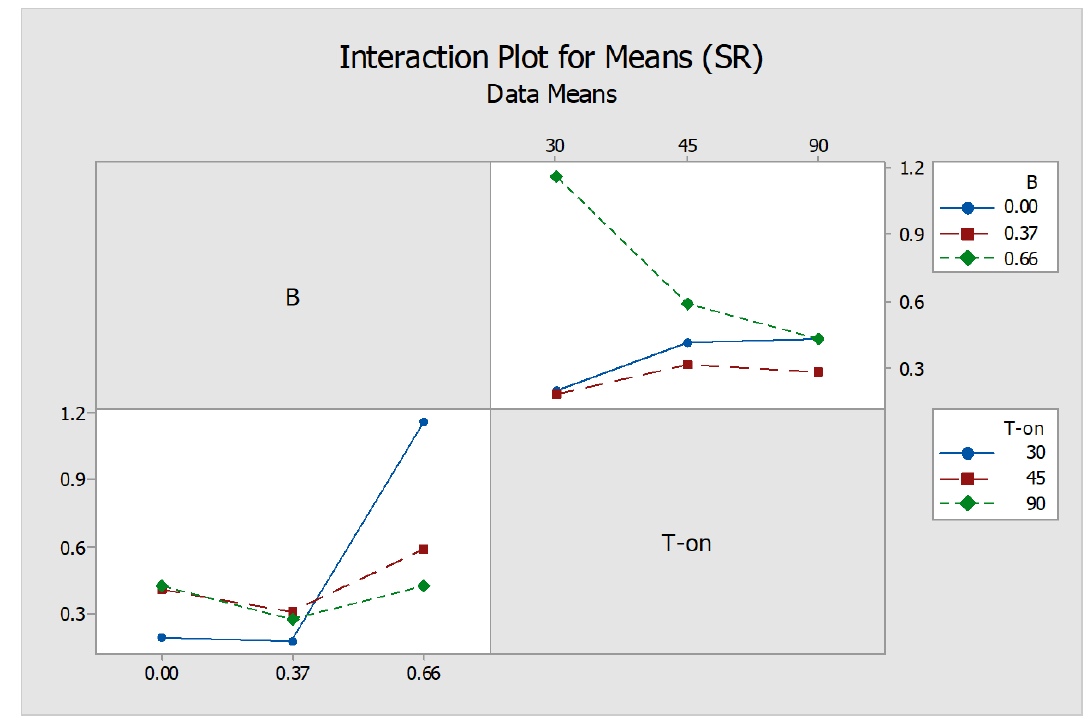
Figure 9. Interaction Plot between Magnetic field intensity (B) and T-on.